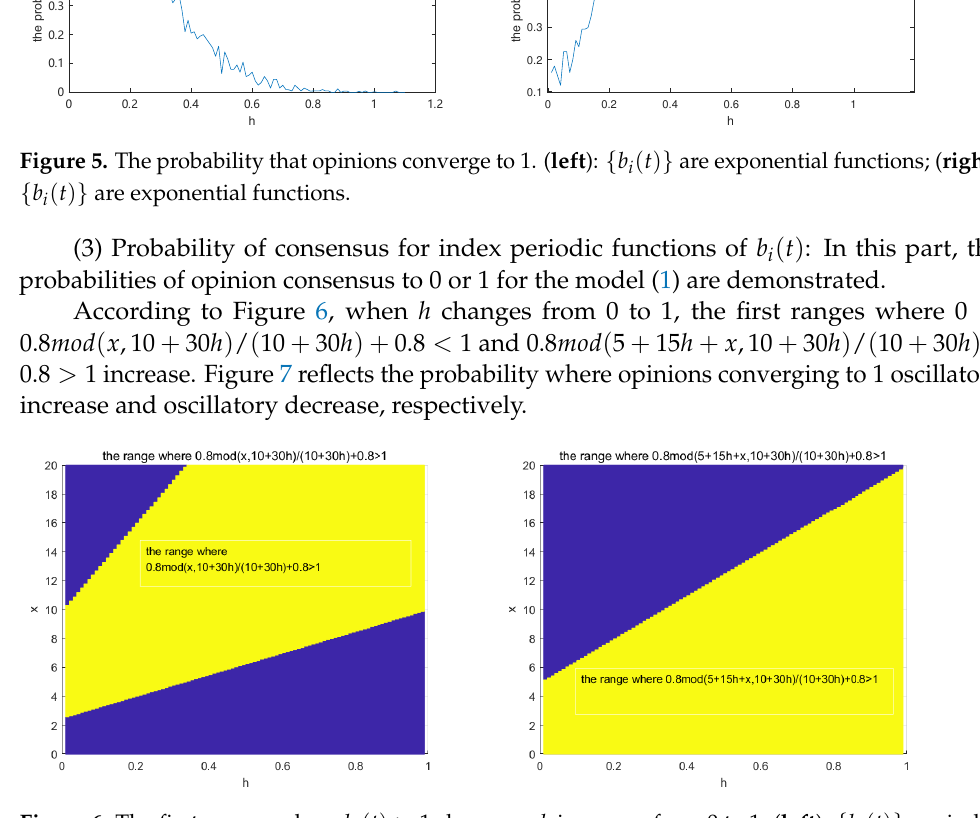
Figure 6. The first ranges where b i ( t ) > 1 change as h increases from 0 to 1. ( left ): { b i ( t ) } are index periodic functions; ( right ): { b i ( t ) } are index periodic functions.